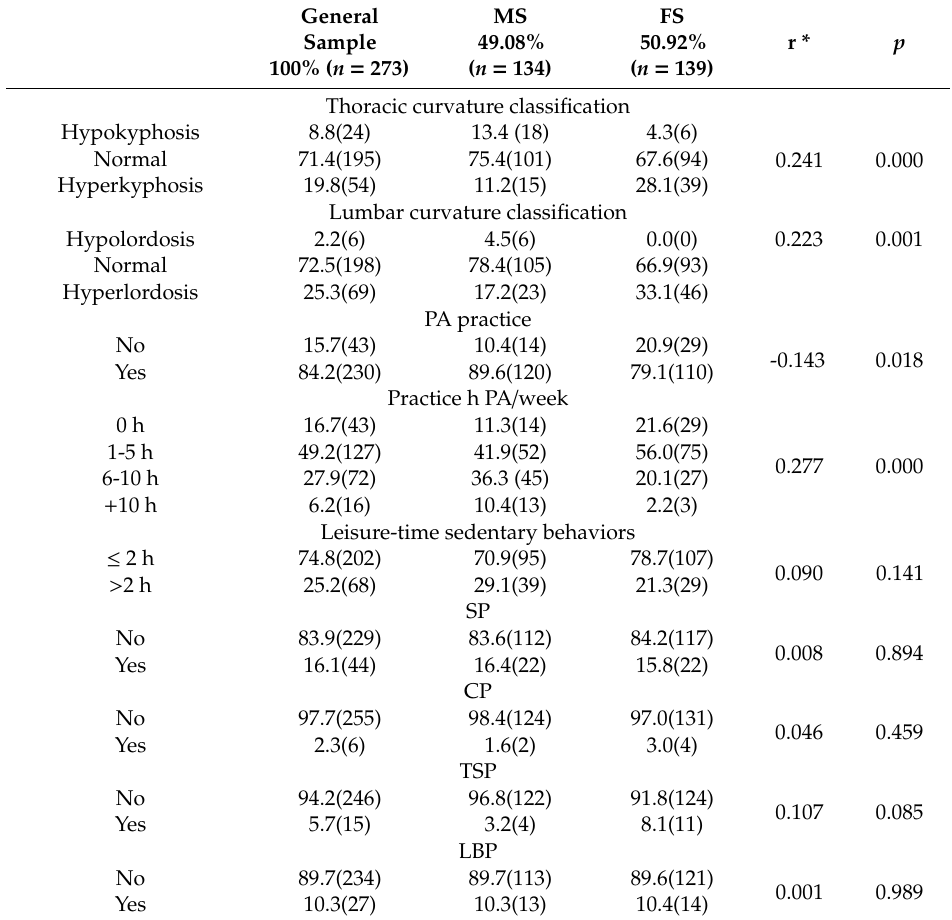
Table 2. Percentages (counts) of curvature classification, PA practice, leisure-time sedentary behaviors and SP and di ff erences between